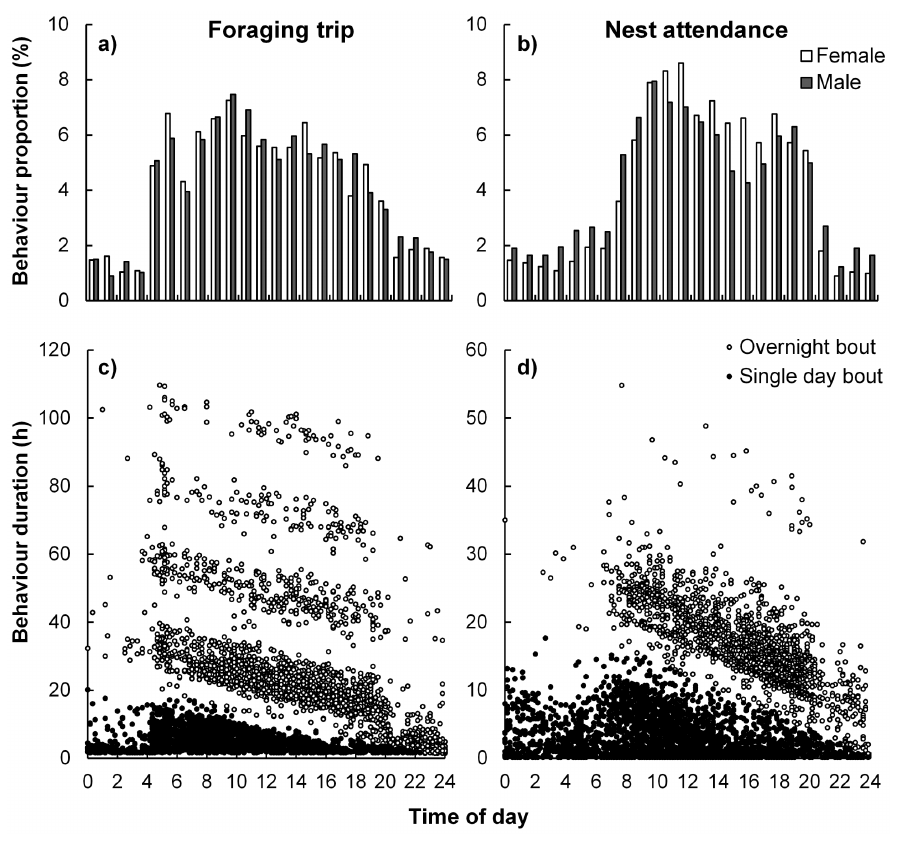
Fig. 3. Timing of bout initiation and duration for breeding Cape gannets at Bird Island, Algoa Bay. Proportion (a and b) and duration (c and d) of foraging trip (left) and nest attendance (right) bouts as a function of bout initiation time are indicated. Behaviour proportions are distinguished by sex (males as dark bars and females as white) and behaviour durations according to those which occurred over one or more midnights (white circles) and those which did not extend over any midnights (dark circles). Trip duration is shown for trips which occurred over fewer than five nights (98.4% of all trips).